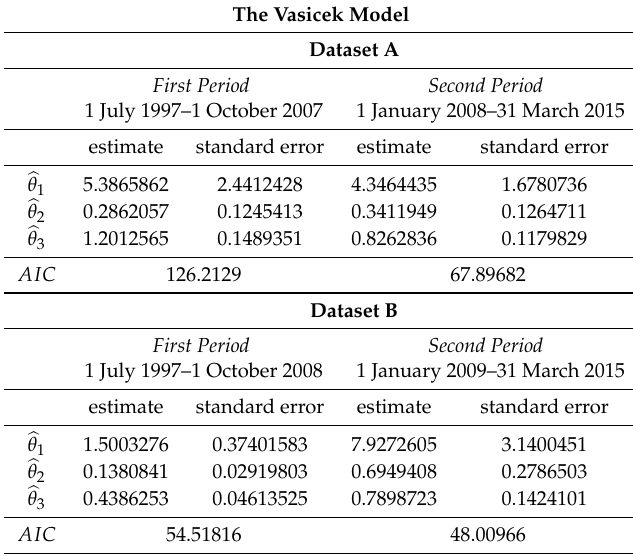
Table 2. ML estimates of Model (5) and the corresponding AIC for the periods indicated by Chow test for Dataset A (on the top) and for Dataset B (on the bottom).